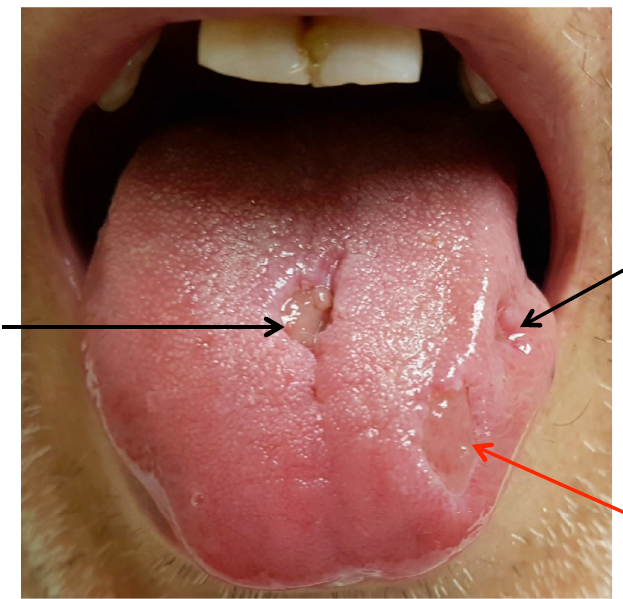
Fig. 2. Cytomegalovirus-induced lingual ulcers (black arrows) and erosion (red